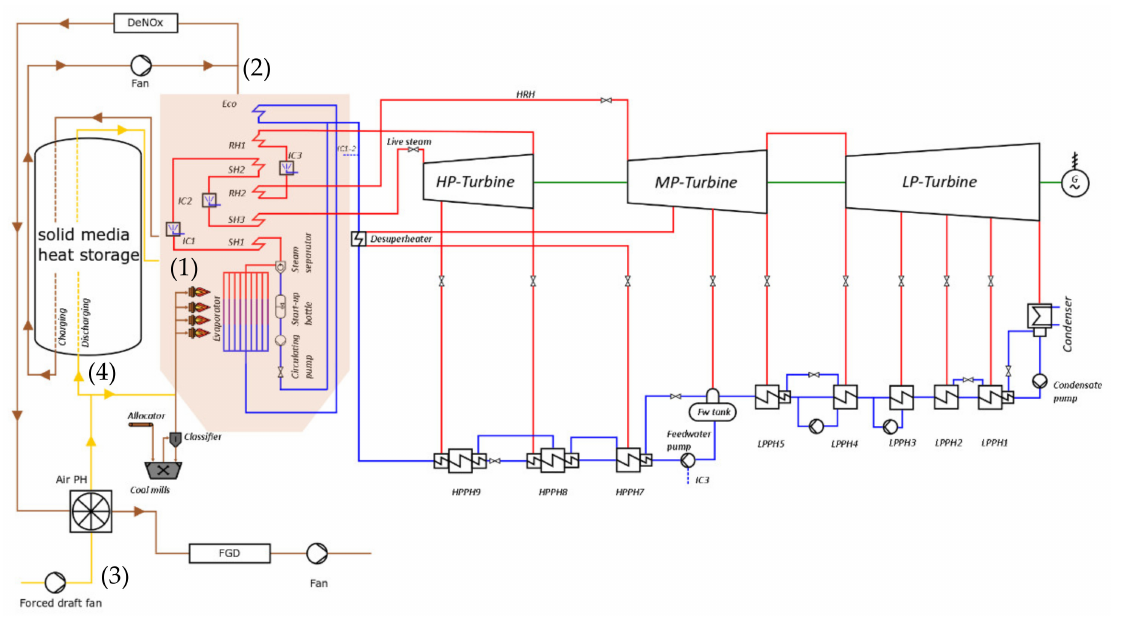
Figure 3. Thermal circuit diagram of an 800-MW power plant with solid media heat storage (concept Flue